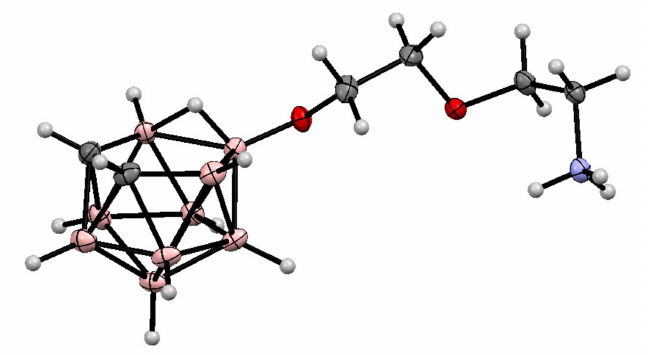
Figure 4. The molecular structure of 10-NH 3 CH 2 CH 2 OCH 2 CH 2 O-7,8-C 2 B 9 H 11 . The charge-compensated nido -carborane-based conjugates with mitonafide were pre- pared in mild conditions by the ring-opening reactions of 1,4-dioxane and tetrahydropyran derivatives of nido -carborane with dimethylamino group of mitonafide [63] (Scheme 15).